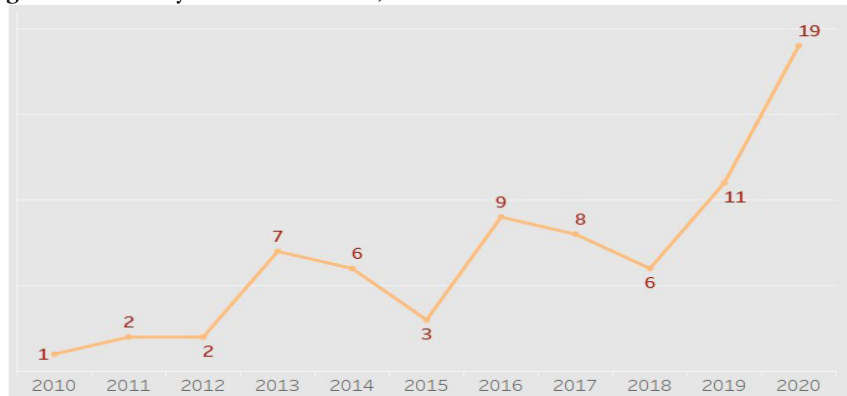
Figure 1: Annual cyber incident totals, 2010–2020